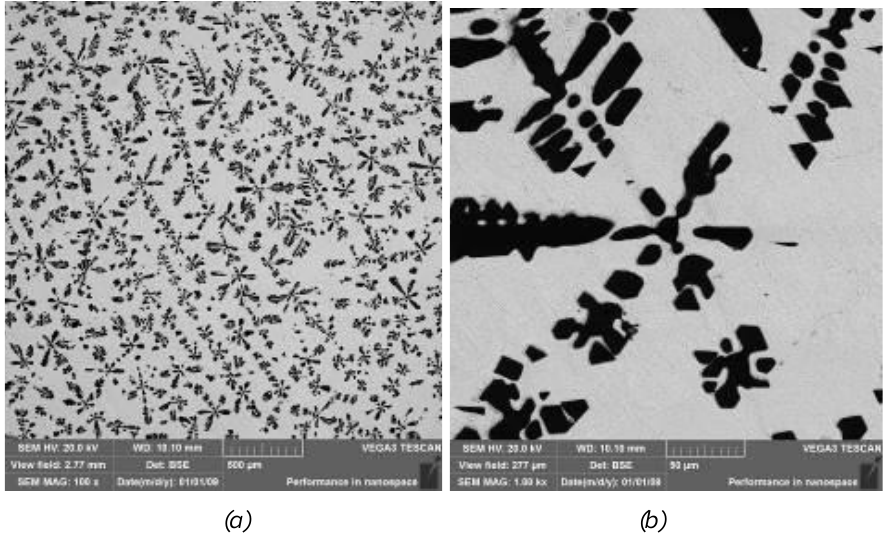
Fig. 3. SEM image of the Bi 72.5 Cu 27.5 alloy: (a) magnification 100X; (b)